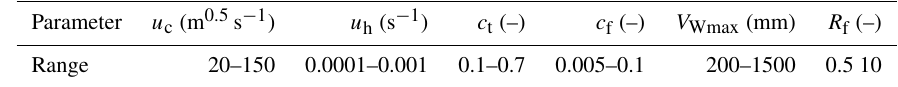
Table 2. Ranges of parameter values considered for the calibration–validation